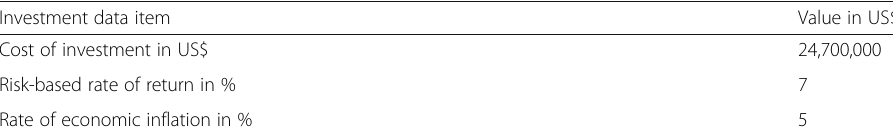
Table 18 El Kosseir investment